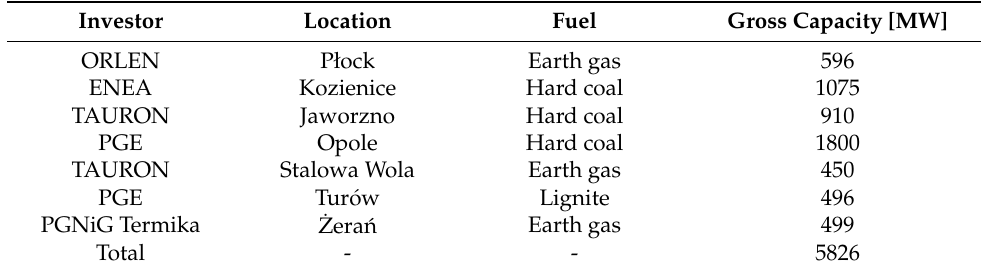
Table 3. Chosen characteristics of Polish power plants.